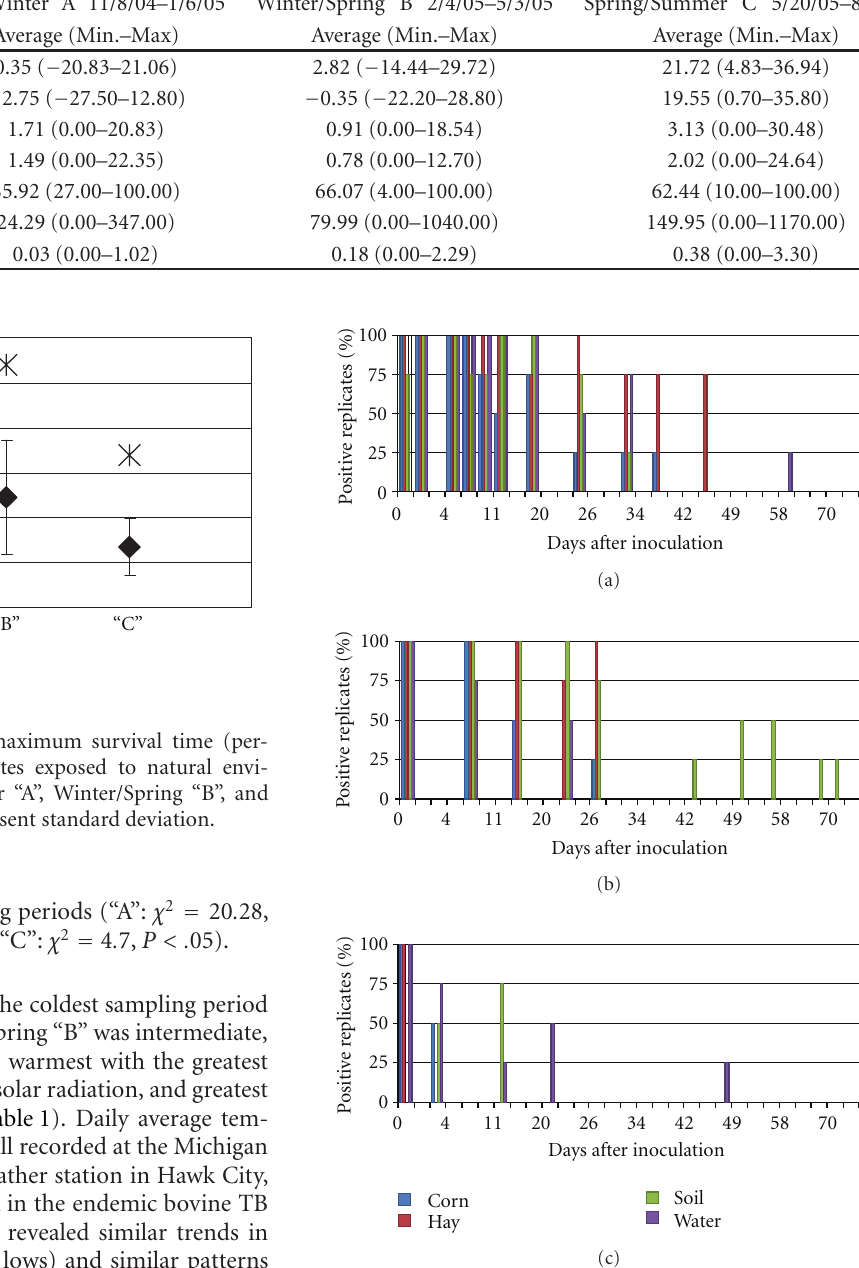
the time from inoculation to first negative after last positive M. bovis sample are presented. The average and maximum survival times were lowest in the Spring/Summer sampling period “C”. The maximum survival time across all substrate types and sampling seasons was recorded in a soil